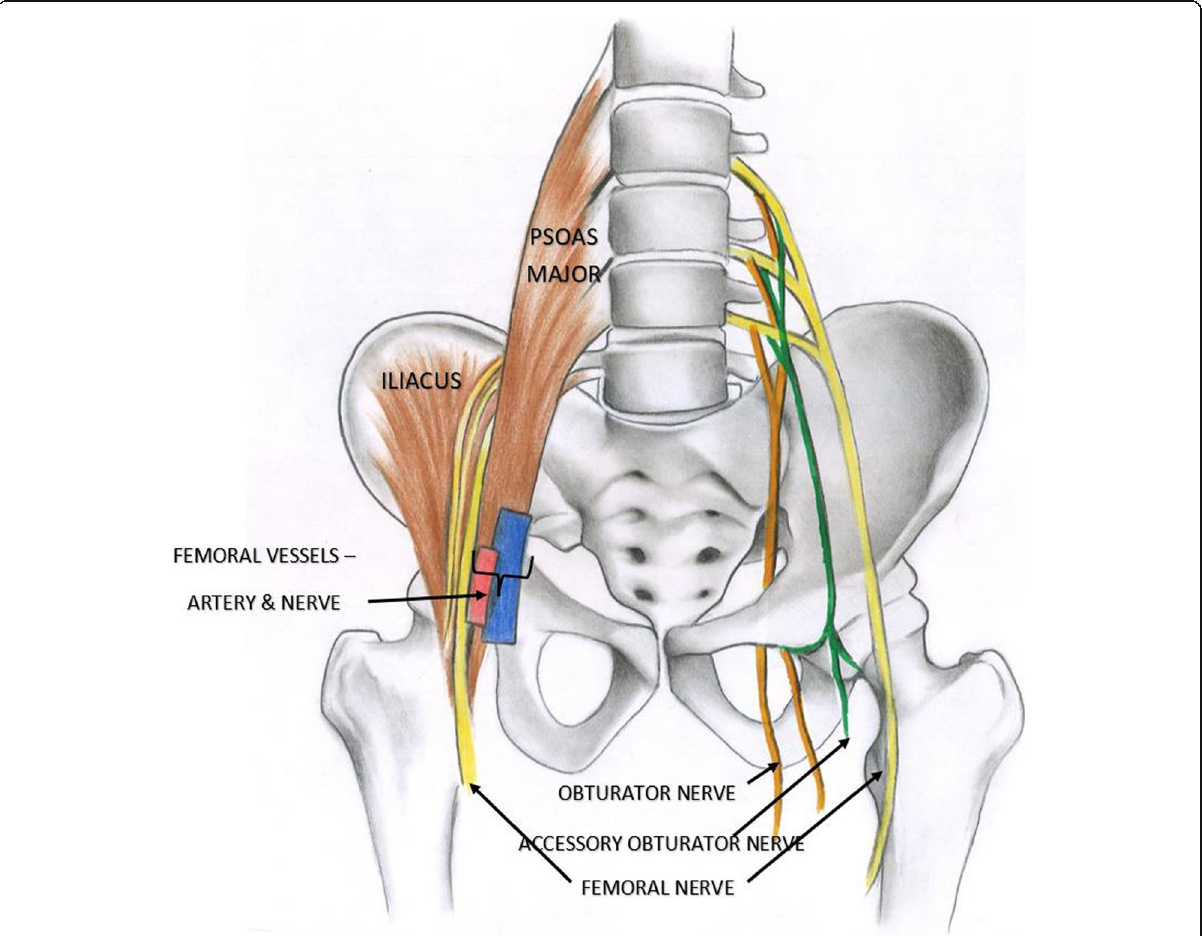
Fig. 2 Branches of the lumbar plexus that contribute to innervation of the hip joint (right side of the picture) and their relation to the adjoining structures (left side of the